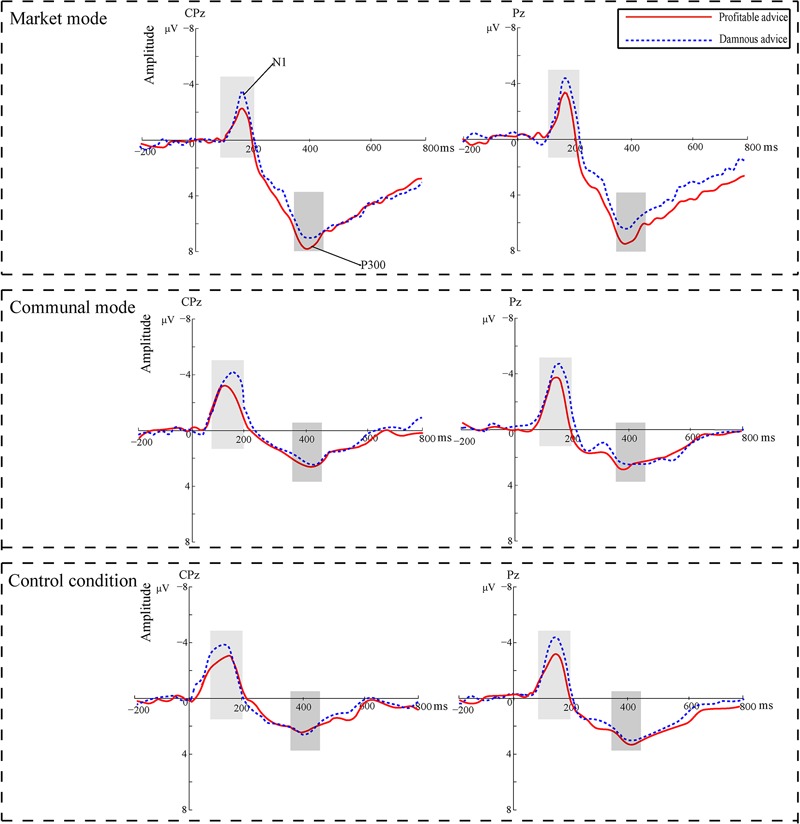
Grand-average ERP waveforms from the CPz and Pz electrode sites.